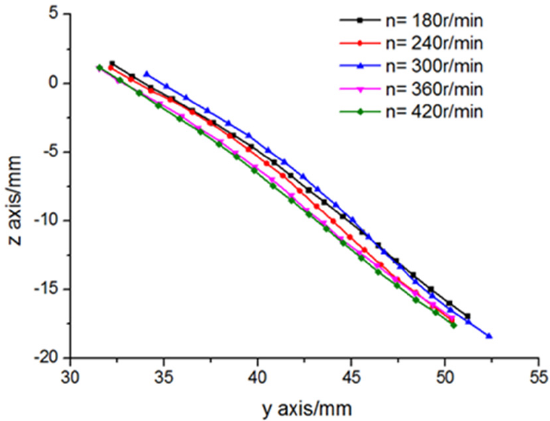
Figure 9. Effect of mandrel rotation rate on straightness.